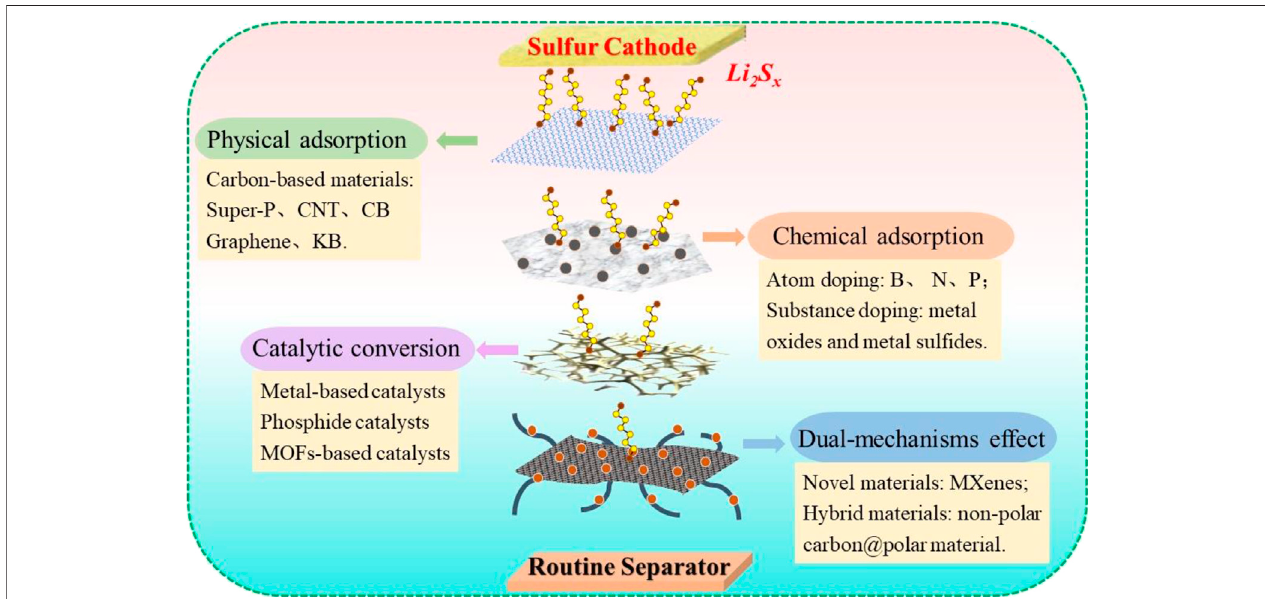
FIGURE 2 | Classi fi cation and function mechanism of functional separators in the cycling process of LSBs.